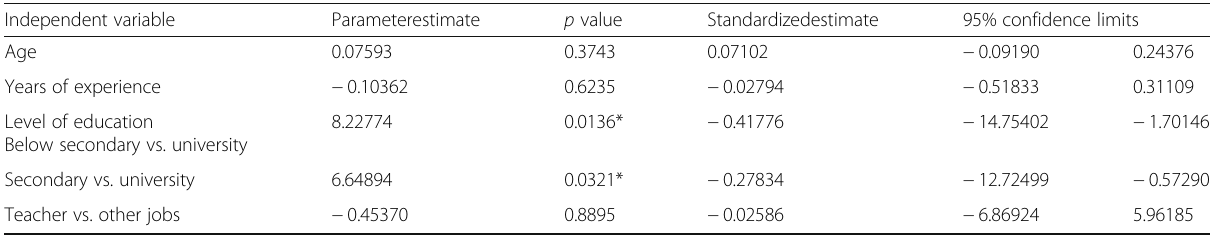
Teacher vs. other jobs *Significant ( p